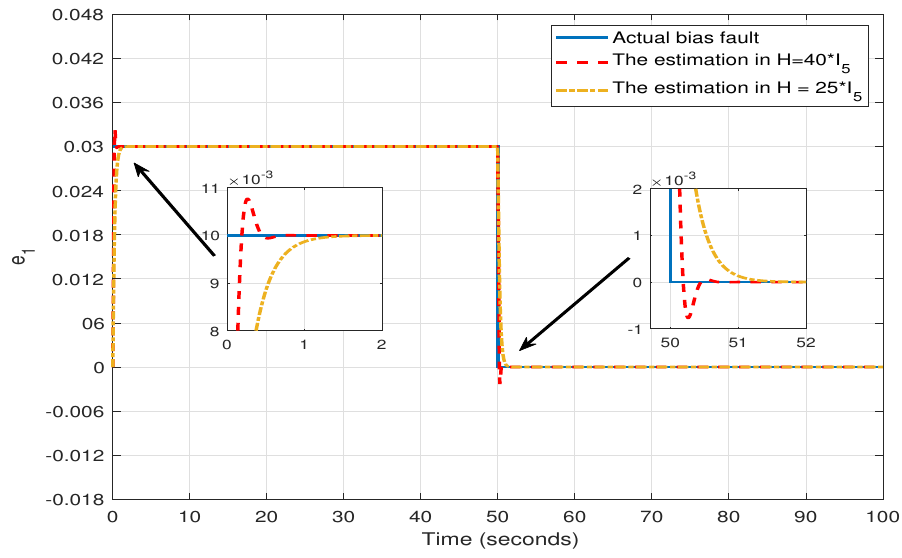
Figure 6. The comparisons of observer performance under different